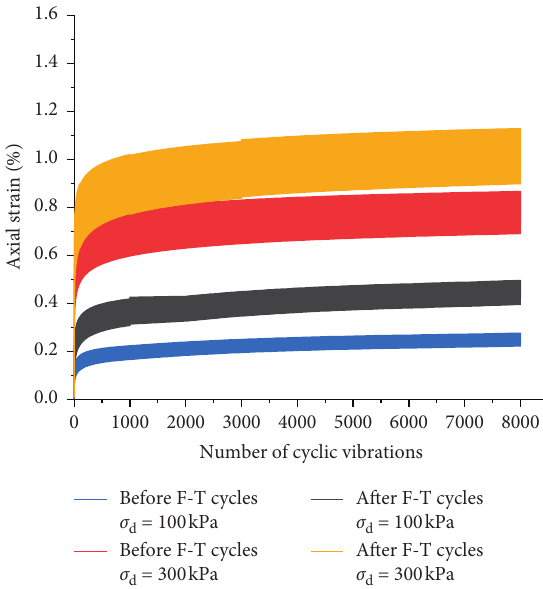
Figure 6: Long-term deformation curves of SOF.